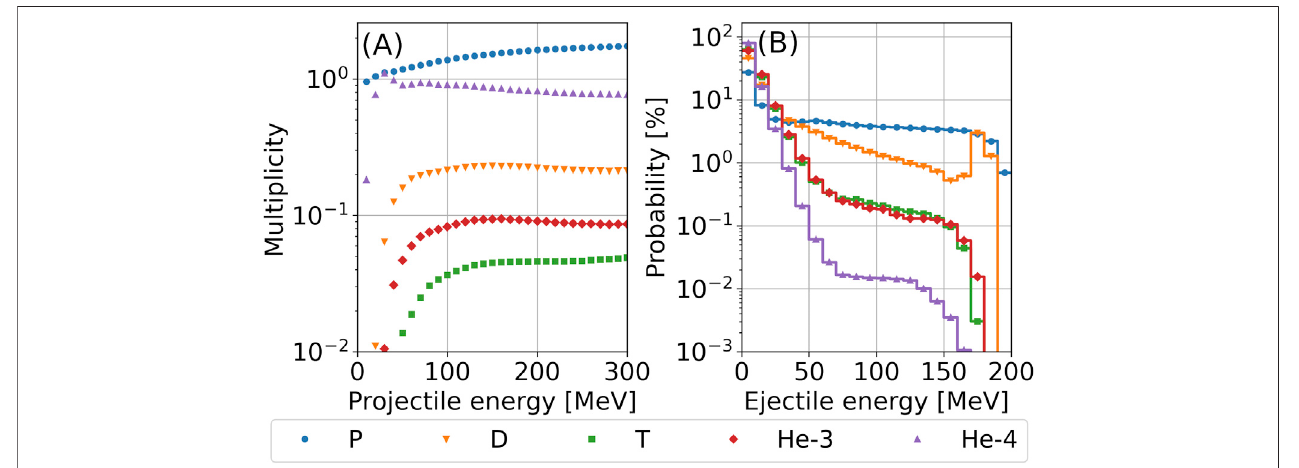
FIGURE 1 | (A) Average number of particles produced per p + 16 O collision as a function of the energy of the incoming proton. (B) For 200 MeV p + 16 O collisions, the angularly integrated probability (in %) ofa secondary particle being produced in a certain energy bin (bin size: 10 MeV) isshown. Abbreviationsstand for Protons (P), Deuterons (D), Tritons (T), Helium-3 ( 3 He) and Helium-4 ( 4